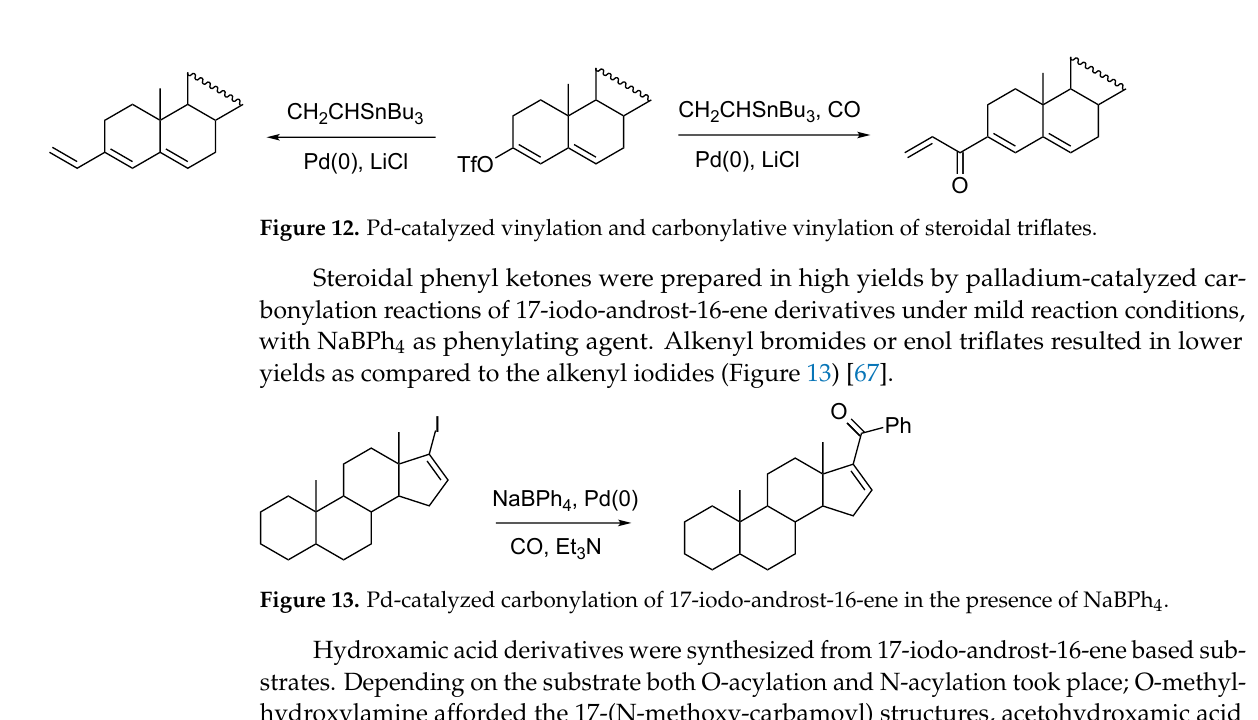
thereby making the O-acylation products dominant